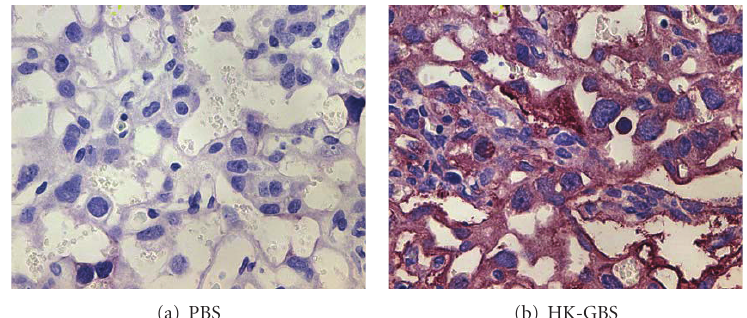
Figure 5: Intrauterine HK-GBS injection induces placental m-calpain expression in a time-dependent manner . Day 14.5 pregnant mice were euthanized 14 hours after exposure to PBS (i) or HK-GBS (ii). Placentas were removed and stained for m-calpain. Data from a representative of three separate experiments is